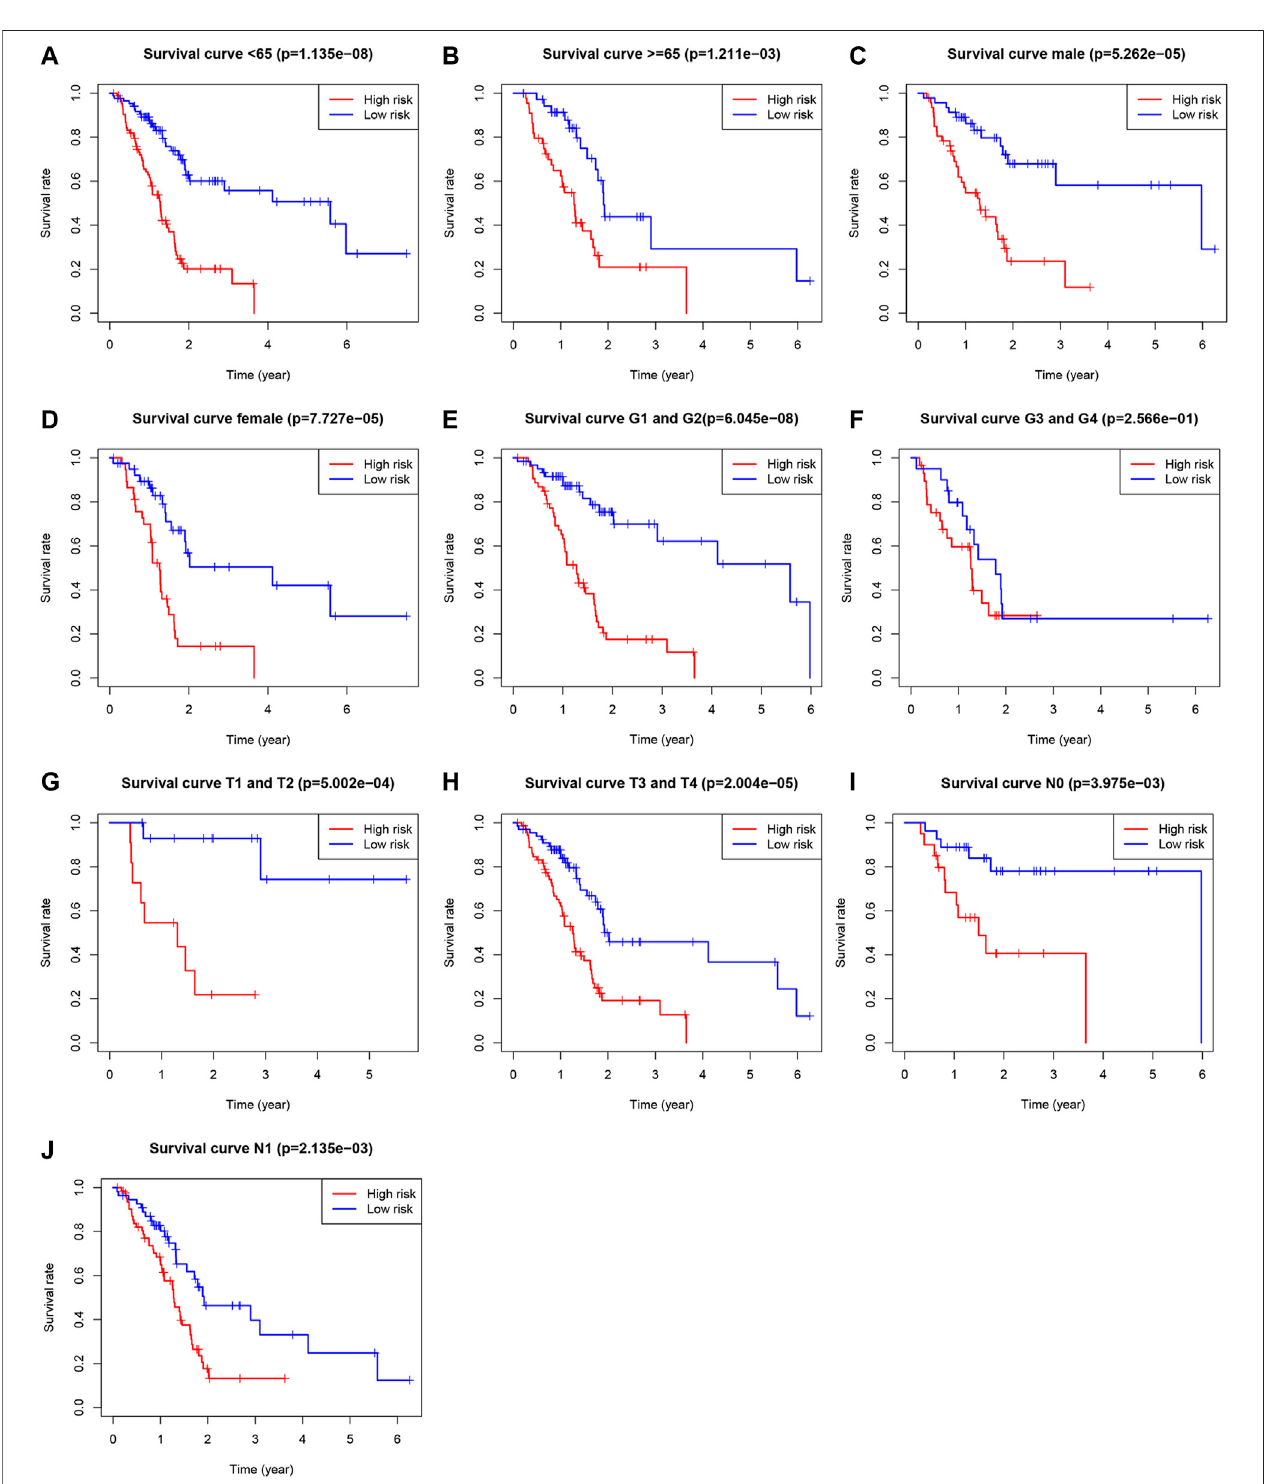
FIGURE6| SurvivalratesofPAADpatientswithhigh-andlow-riskpatientswithPAADinthesubgroupsbasedonclinicopathologicalcharacteristics. (A) Subgroup of age < 65 years. (B) Subgroup of age ≥ 65 years. (C) Male subgroup. (D) Female subgroup. (E) G1 and G2 subgroups. (F) G3 and G4 subgroups. (G) T1 and T2 subgroups. (H) T3 and T4 subgroups. (I) N0 subgroup. (J) N1 subgroup.